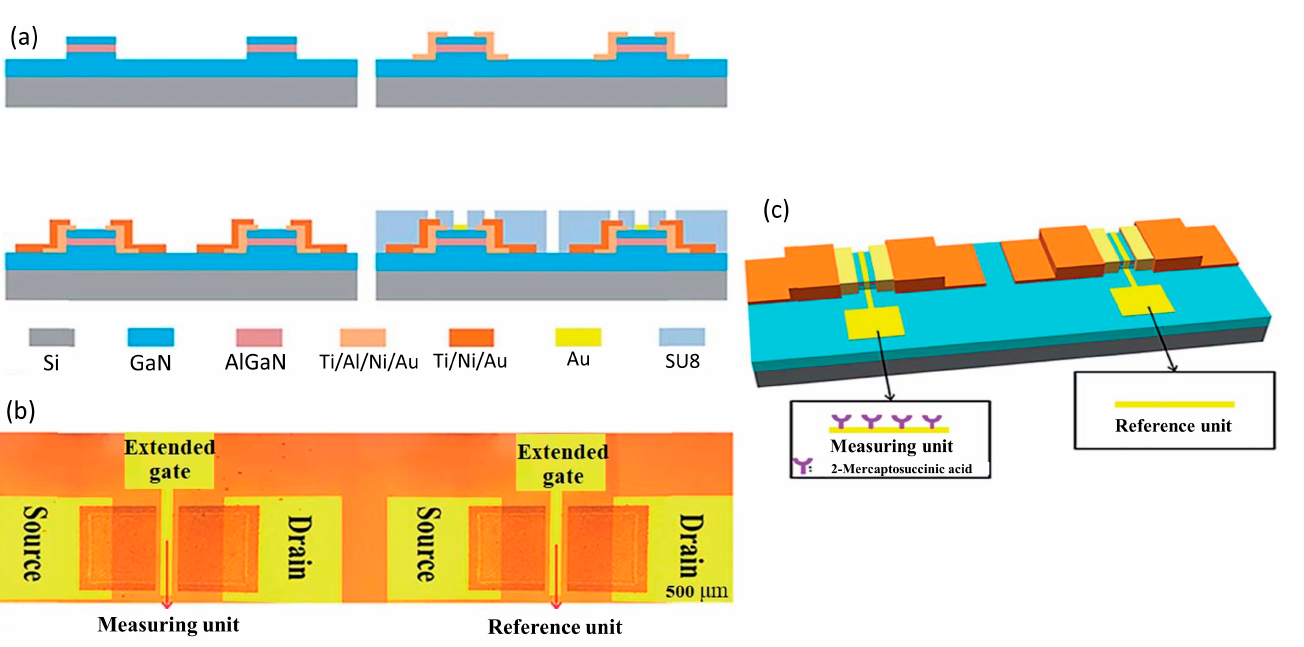
Figure 6. Illustration of ( a ) the fabrication process ( b ) the real image and ( c ) the three dimensional structure of the differential HEMT sensor. Reprinted from reference [128]. Copyright 2019, with permission from The Royal Society of Chemistry .